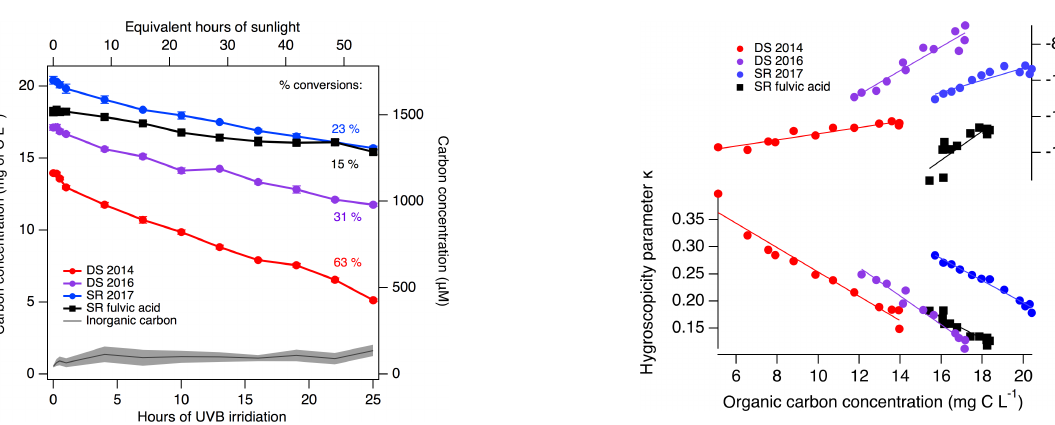
Figure 4. Decrease in the dissolved organic carbon (in both mgCL − 1 and in µM) present in DOM upon UVB irradiation. Both the organic (as non-purgeable organic carbon) and inorganic car- bon (as carbonates) were quantified by a TOC analyser, which was calibrated using standard solutions of terephthalic acid and carbon- ate, respectively. Note that dissolved CO 2 is not quantified by TOC analysis. The inorganic carbon is averaged for all samples with the standard deviation in grey. The percentage values indicate the con- versions of original organic matter into photoproducts.